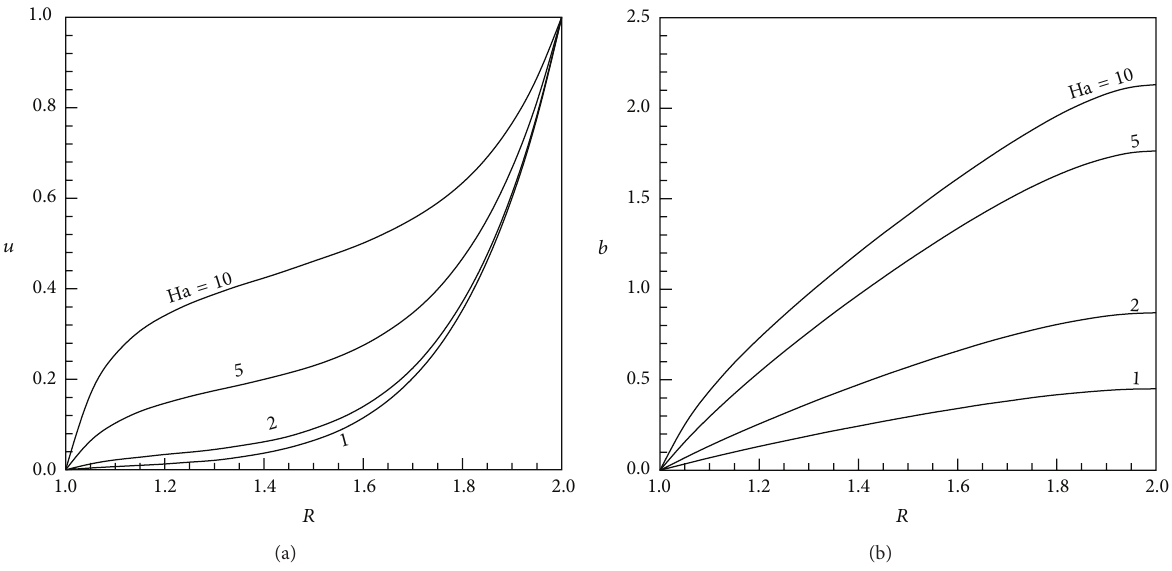
Figure 5: Various profiles forDa = 10 −2 and different values of Ha when theinnercylinder isperfectly insulated while theouter oneisperfectly conducting: (a) velocity and (b) induced magnetic